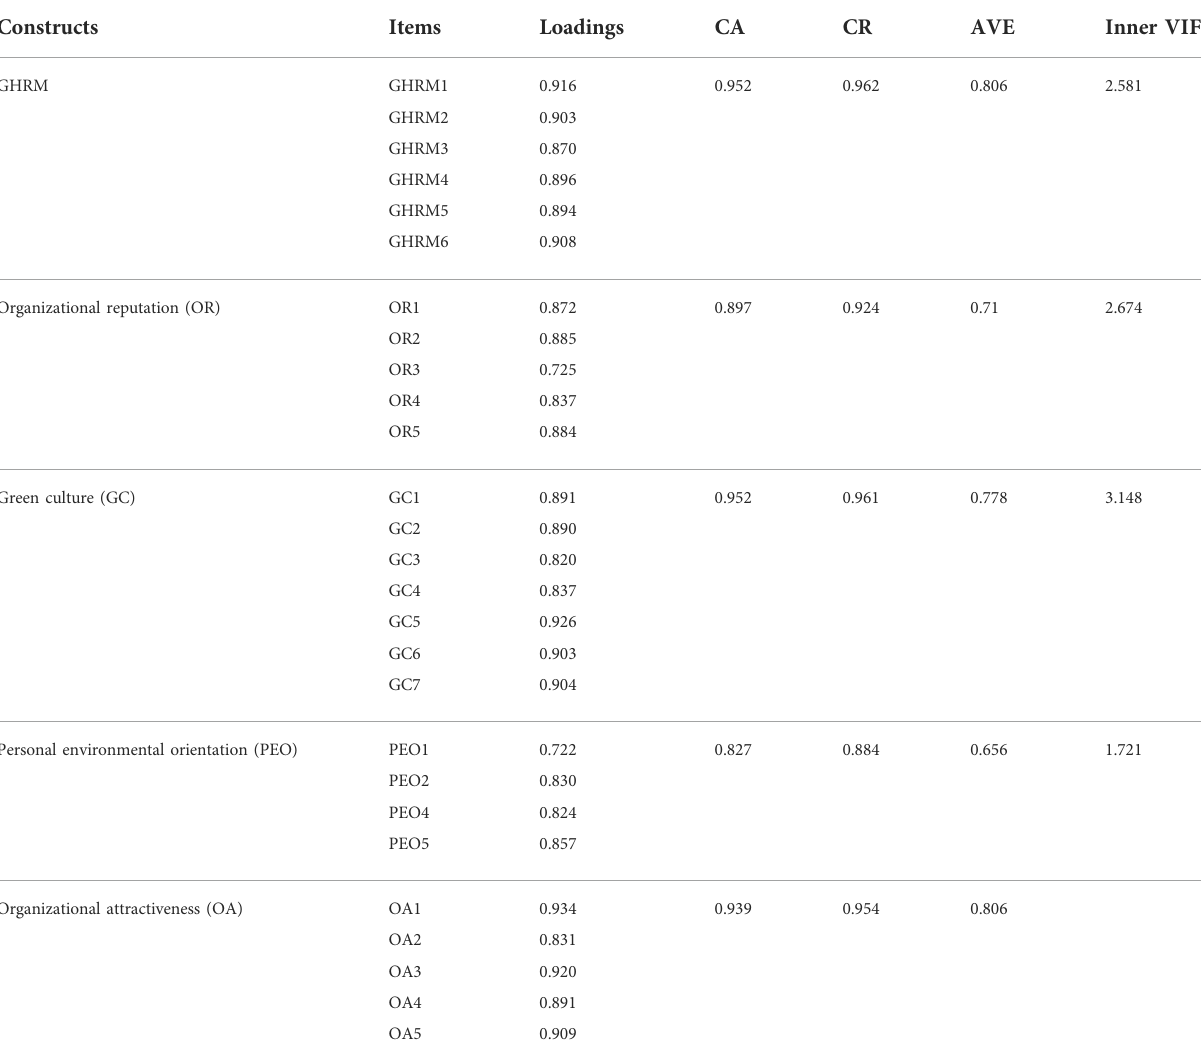
TABLE 2 Measurement